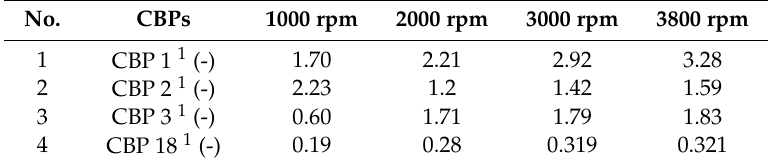
Table 4. Evaluated CBPs (Table 1) of the sub-systems SS 1–3 at full-load operating points. No.